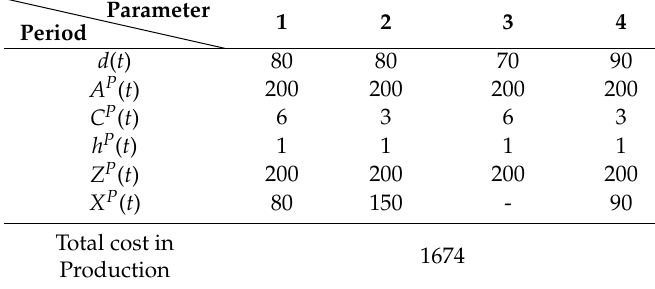
Table 3. Production Model result.